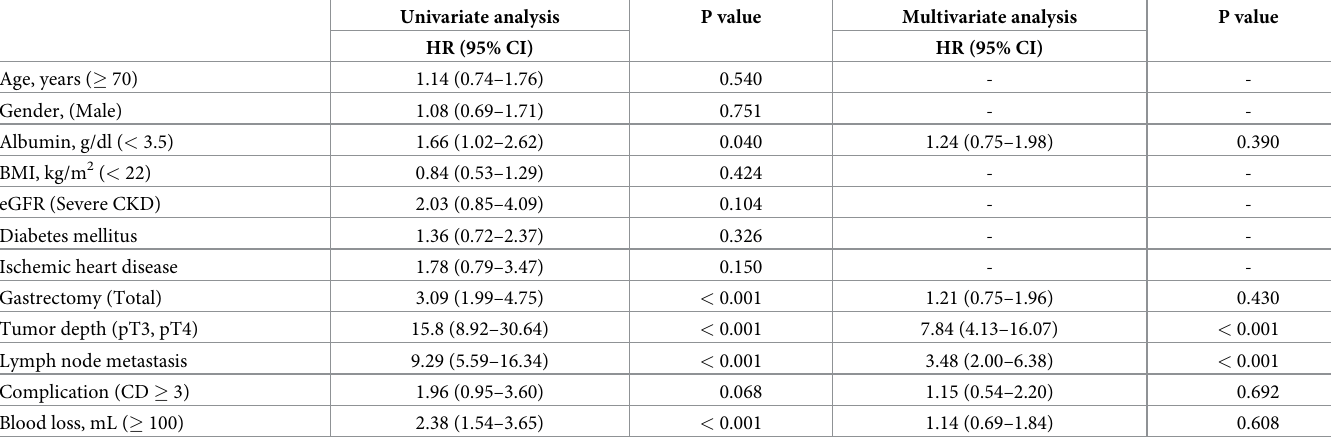
Table 5. Uni- and multivariate analyses of factors predicting Cancer-specific survival